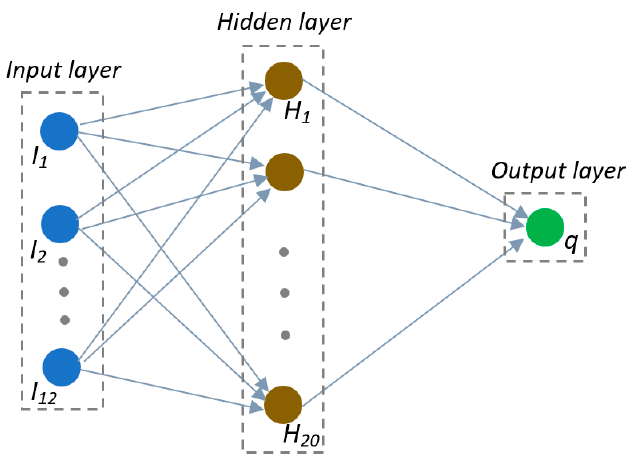
Figure 1. Schematic diagram of an MPNN model.